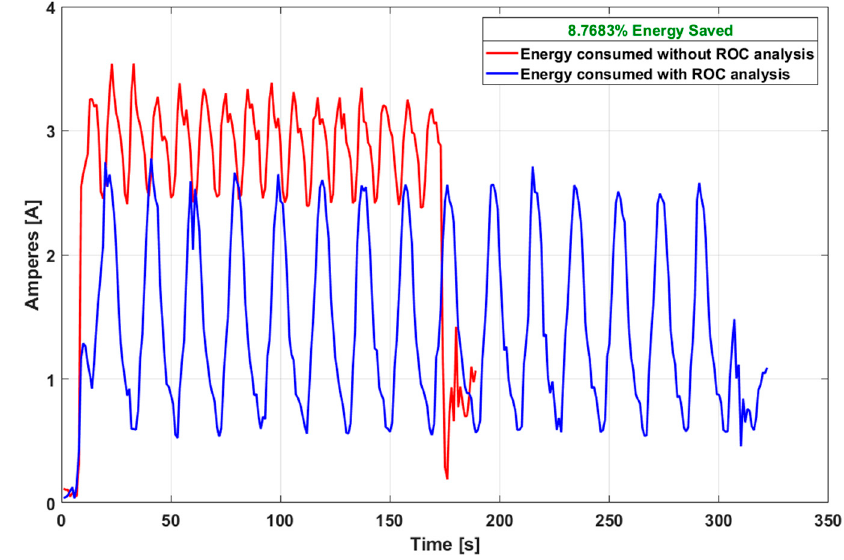
Figure 14. Measurement of consumed currents.